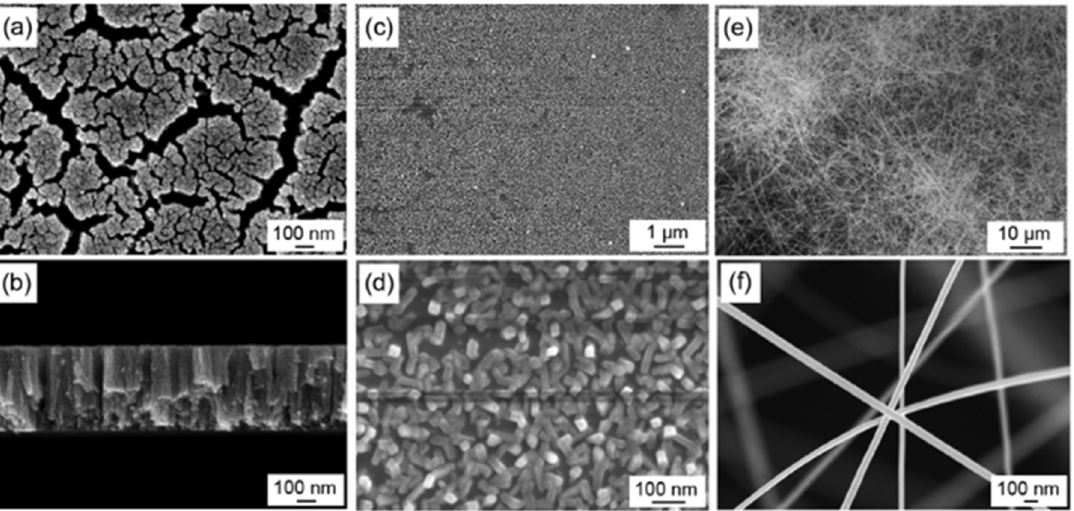
Figure 21. ( a ) Surface and ( b ) cross-sectional field of the emission scanning electron microscopy (FE-SEM) images of SnO 2 nanofilms. ( c ) Low- and ( d ) high-magnification FE-SEM images of SnO 2 nanorods. ( e ) Low- and ( f ) high-magnification FE-SEM images of SnO 2 nanowires [105]. Copyright (2015), with permission from Elsevier.